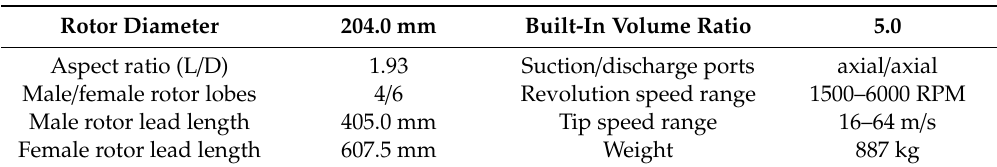
Table 1. Main geometrical and operating data of modelled expander (courtesy of Howden Compressors Ltd.).